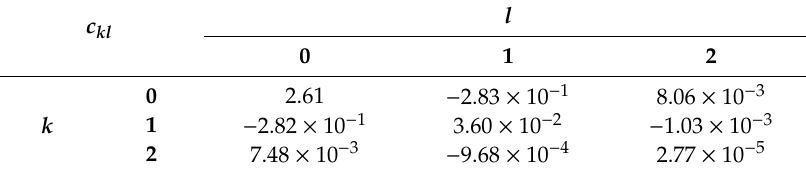
Figure 4. Relationship between SiAlON layer thickness and ERR for interface crack initiation due to thermal stress at ( a ) SiC/SiAlON, ( b ) SiAlON/mullite and ( c ) mullite/YbDS interfaces with various mullite layer thicknesses. Table 9. Coefficients for polynomial approximation of 𝒢 (cid:2919)(cid:2924)(cid:2919)(cid:2930),(cid:2903)(cid:2885)/(cid:2897)(cid:2931)(cid:2930)(cid:2918) (ℎ (cid:2903)(cid:2885) , ℎ (cid:2897)(cid:2931) ) in Equation (5), 𝑐 (cid:3038)(cid:3039) 1 .